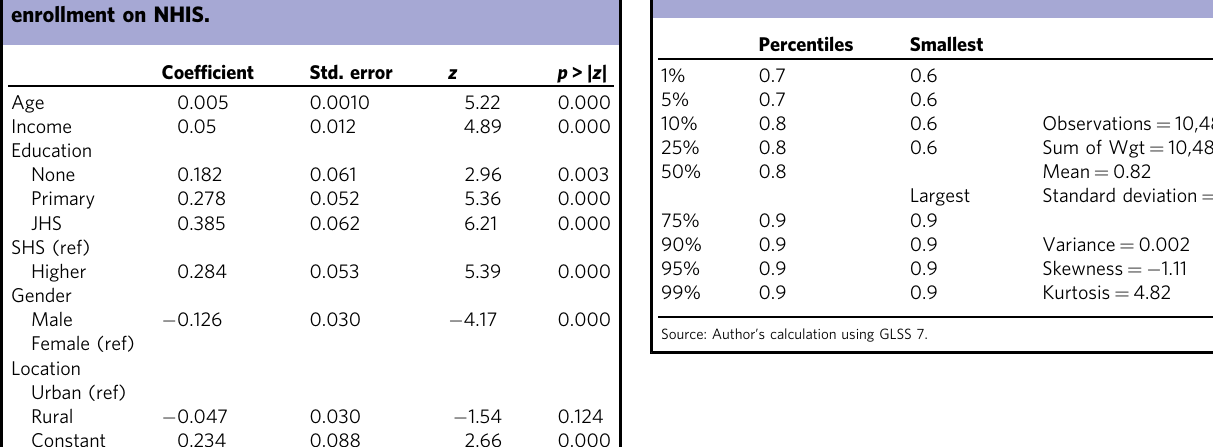
Table 5 Estimated propensity score in percentiles.